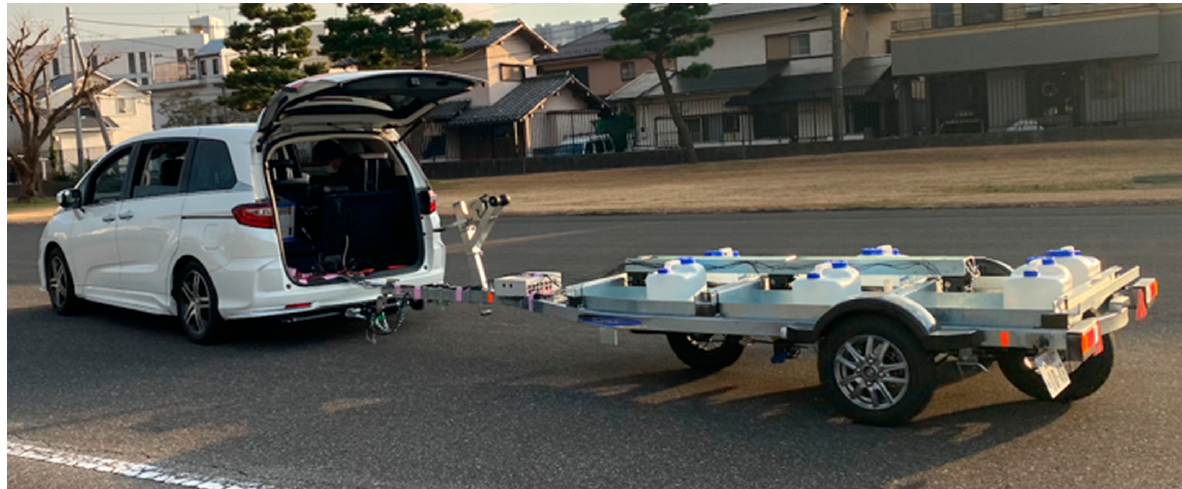
Figure 14. Constructed measurement trailer system.